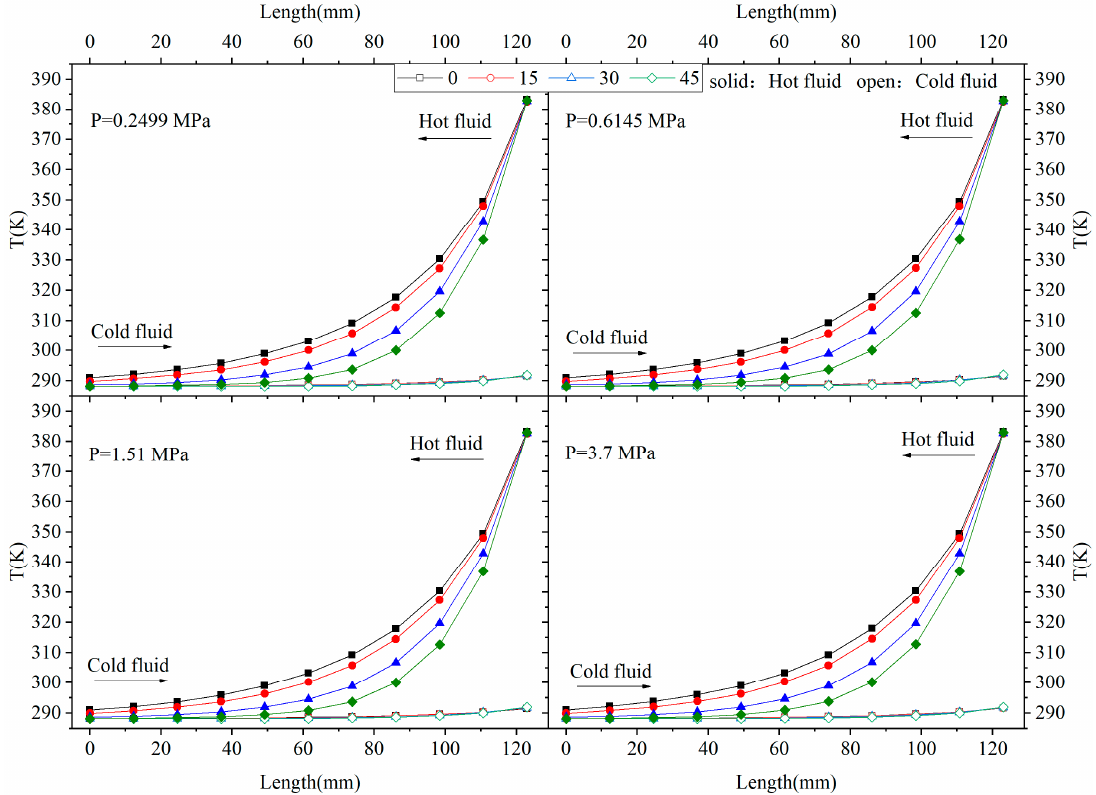
Figure 3. Temperature distribution of the countercurrent flow.